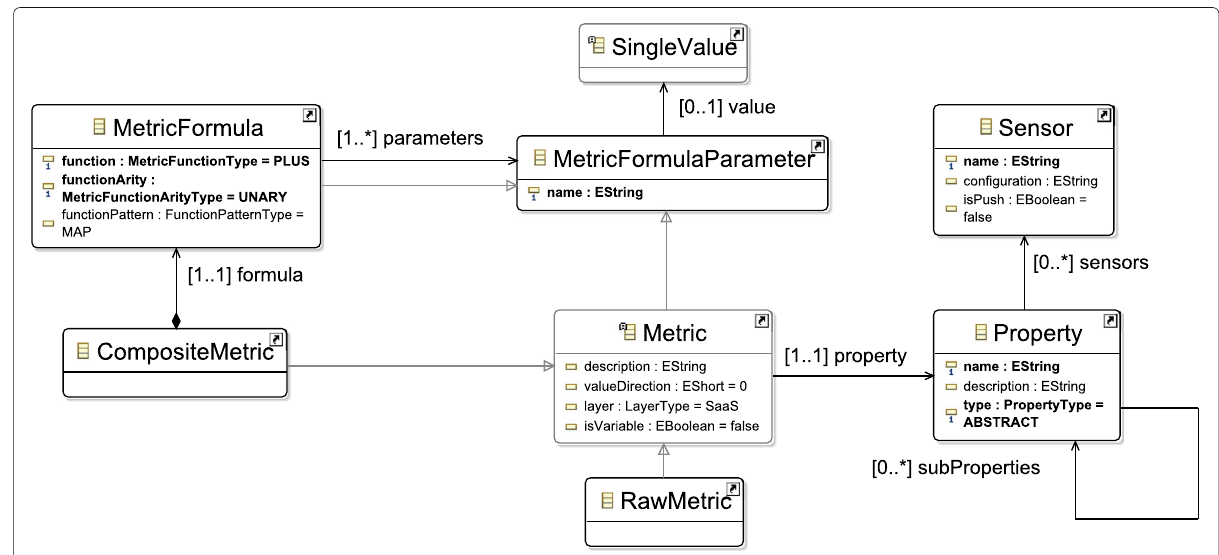
Fig. 6 The Metric concept and its